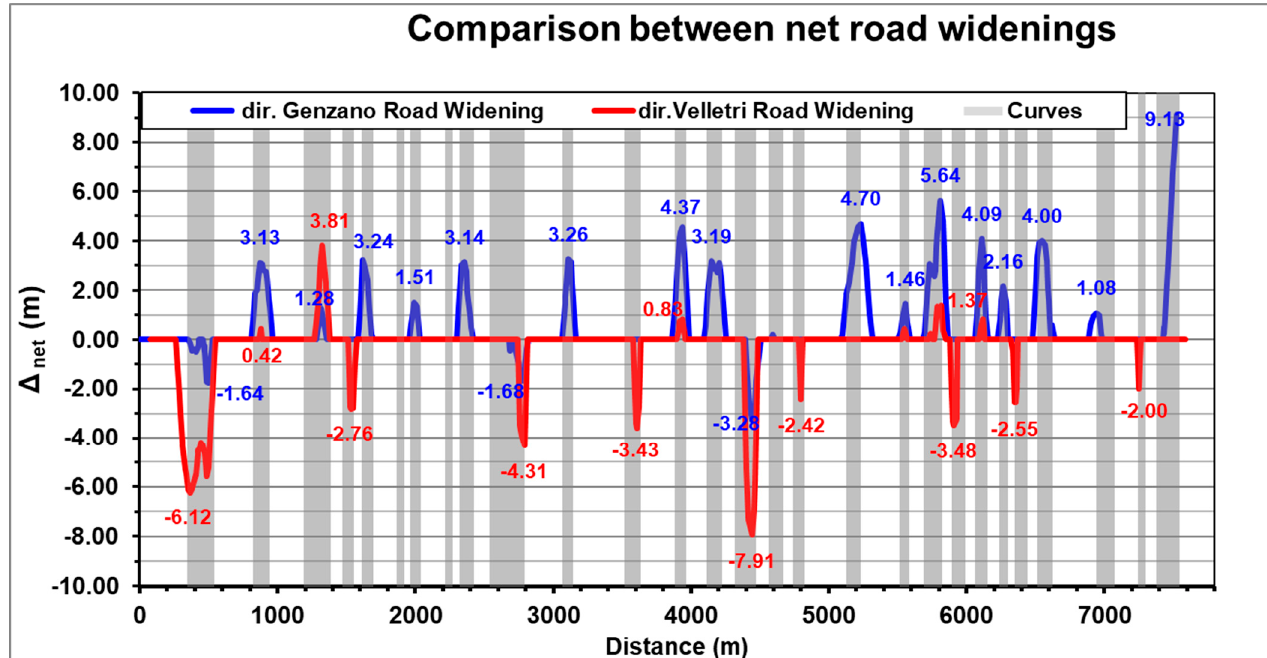
Figure 5. Road widenings in the two travel directions of the S.S.7.